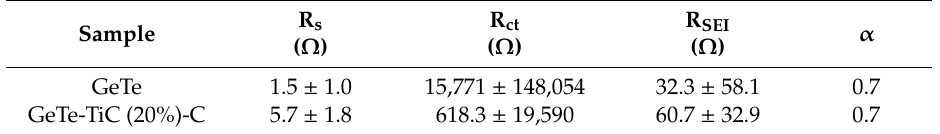
Figure 7. Nyquist plots for electrochemical impedance spectroscopy (EIS) spectra of GeTe and GeTe-TiC (20 %)-C electrodes ( a ) after 100 cycles, with ( b ) the corresponding equivalent circuit. (Z real + Z imag ) plots of GeTe electrode ( c ) and GeTe-TiC (20 %)-C electrode ( d ). Table 2. EIS data of GeTe and GeTe-TiC-C electrodes after 100 cycles without constraint verification.